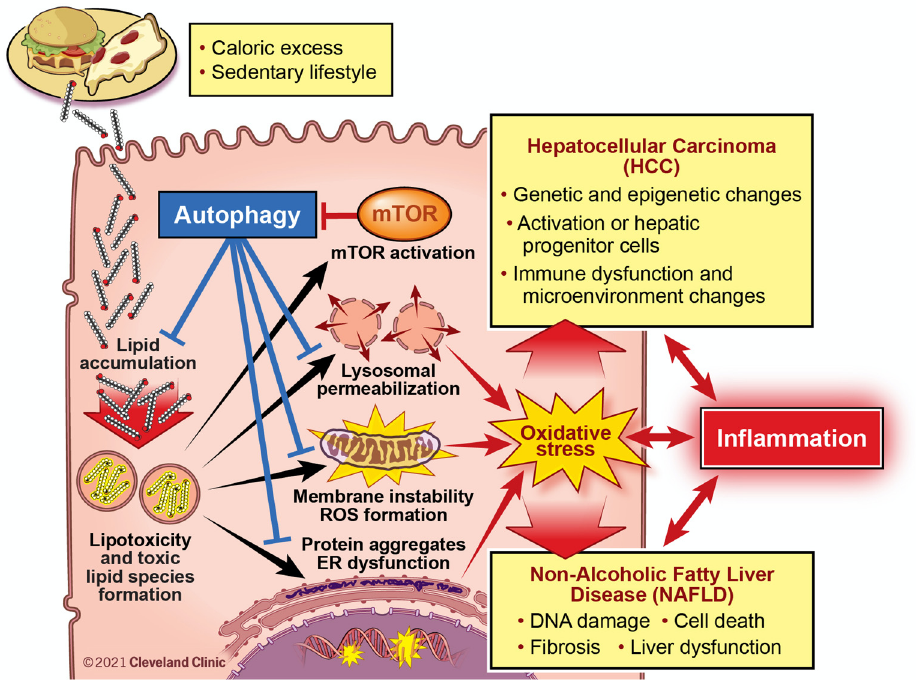
Figure 2. Targeting Lipotoxicity-Driven Pathways to Reduce NAFLD Progression and Prevent HCC Development. The initiating event in NAFLD is lipid accumulation, and it is generally accepted that “lipotoxicity” occurs where intermediates in lipid biosynthesis can act as signaling molecules or alter other cellular processes to promote liver disease. Lipotoxicity is associated with many cellular pathways including increased oxidative stress, endoplasmic reticulum (ER) stress, mitochondrial dysfunction with reactive oxygen species (ROS) formation, and lysosomal dysfunction with lysosomal membrane permeabilization (LMP). Collectively, the pathways initiated by lipotoxicity may lead to NAFLD progression via DNA damage and cell death, inflammatory cell recruitment, activation of pro-fibrotic programs, as well as local and systemic insults. Autophagy is central to several of these lipotoxicity-driven pathways, and therapies impacting autophagic flux during NAFLD progression may hold promise.